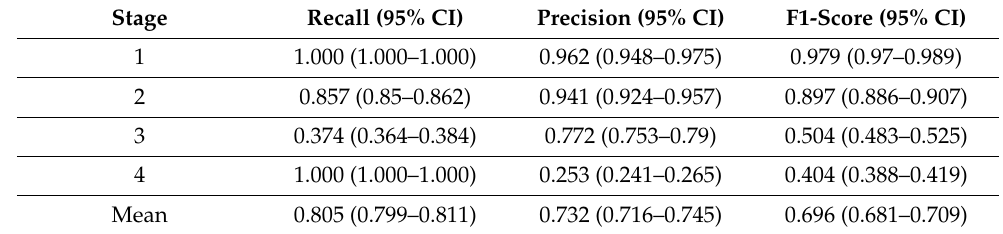
Table 3. Evaluation of the proposed framework for classifying periodontitis stages for each